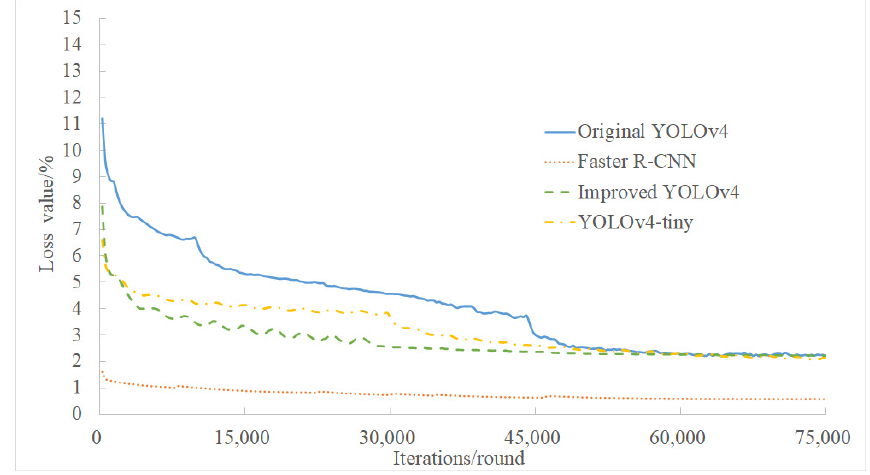
Figure 8. Loss value of the four models.